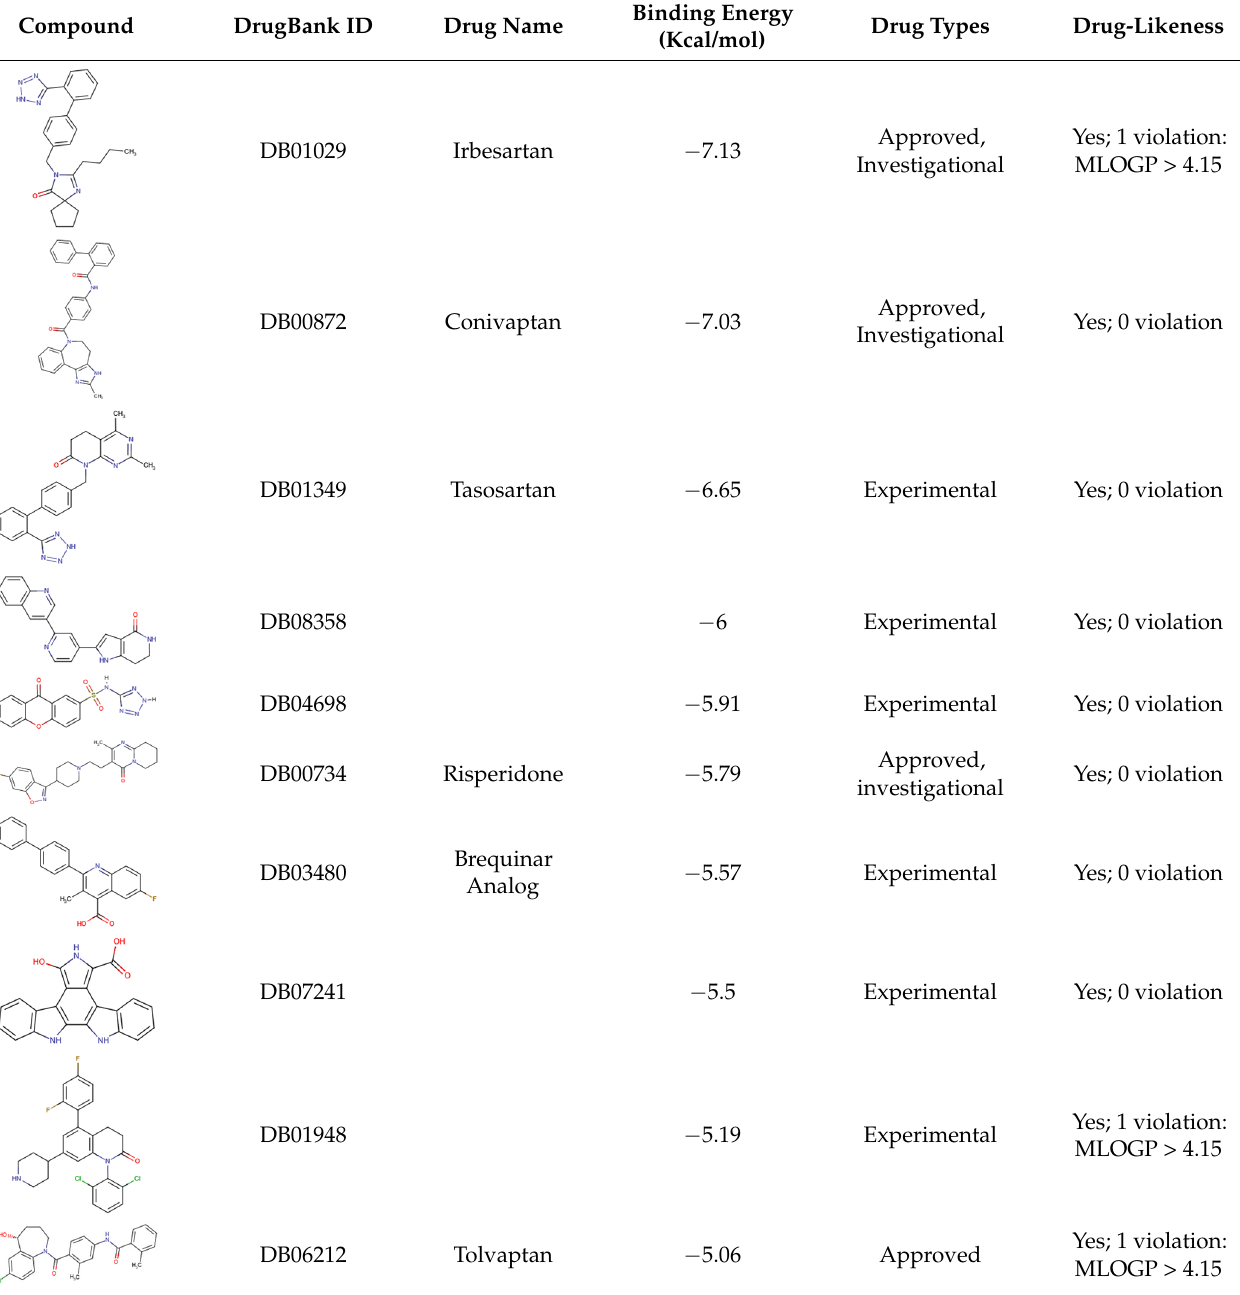
Table 2. The hit compounds by virtual screening and its inhibitory activity against DHCR24 .